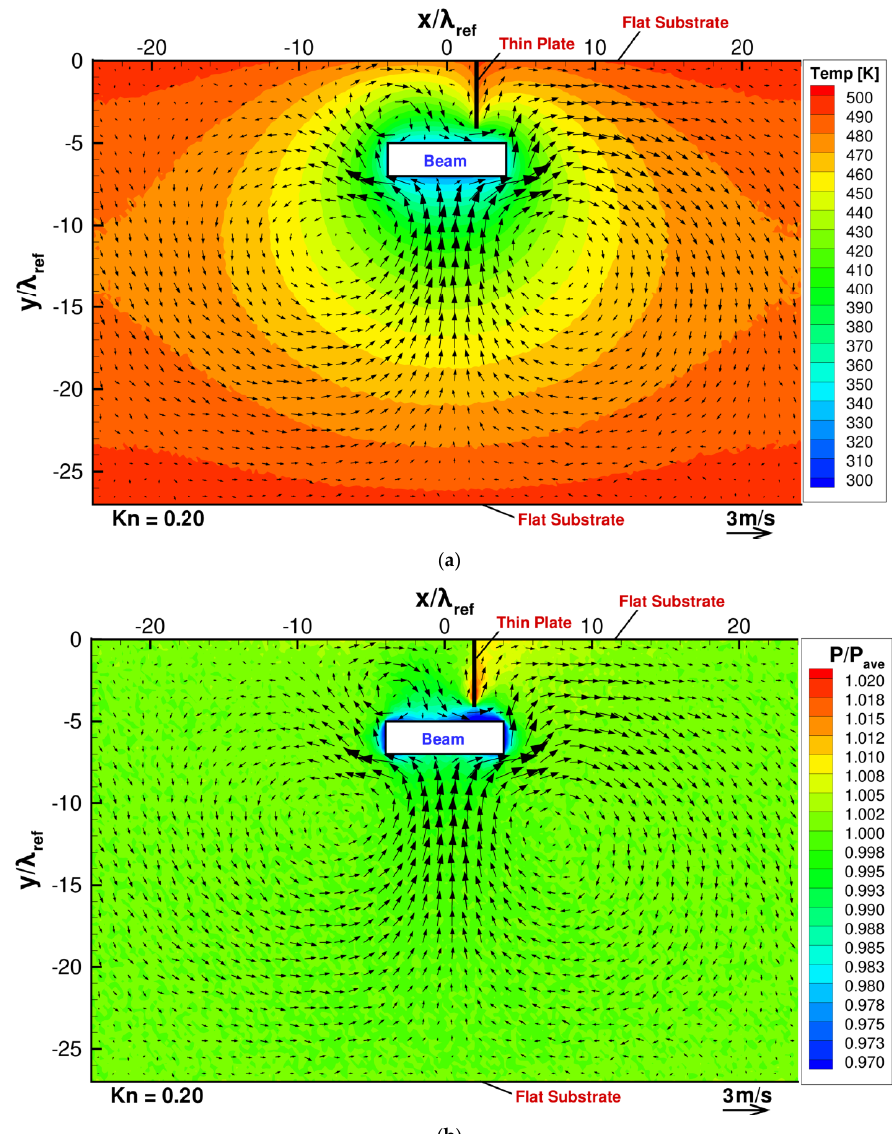
Figure 5. ( a ) Flow and temperature distribution and ( b ) pressure distribution, when the beam is placed close to a heated thin plate mounted on a substrate, at Kn =